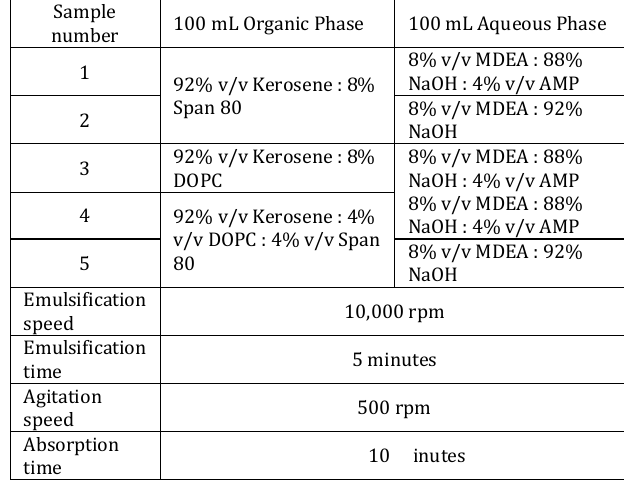
Table 2: Formulation and condition used during emulsion